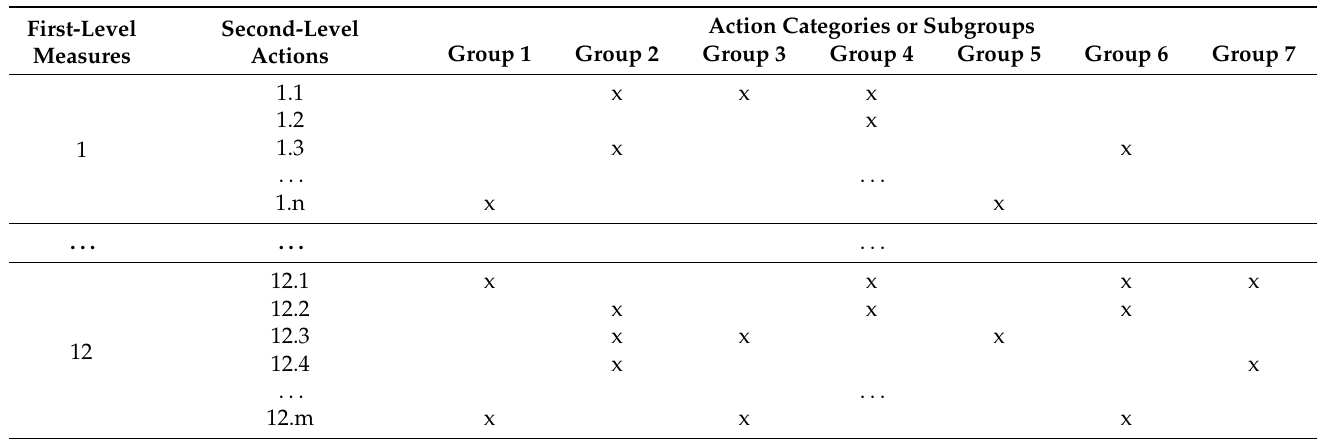
Table 3. Example of a typical